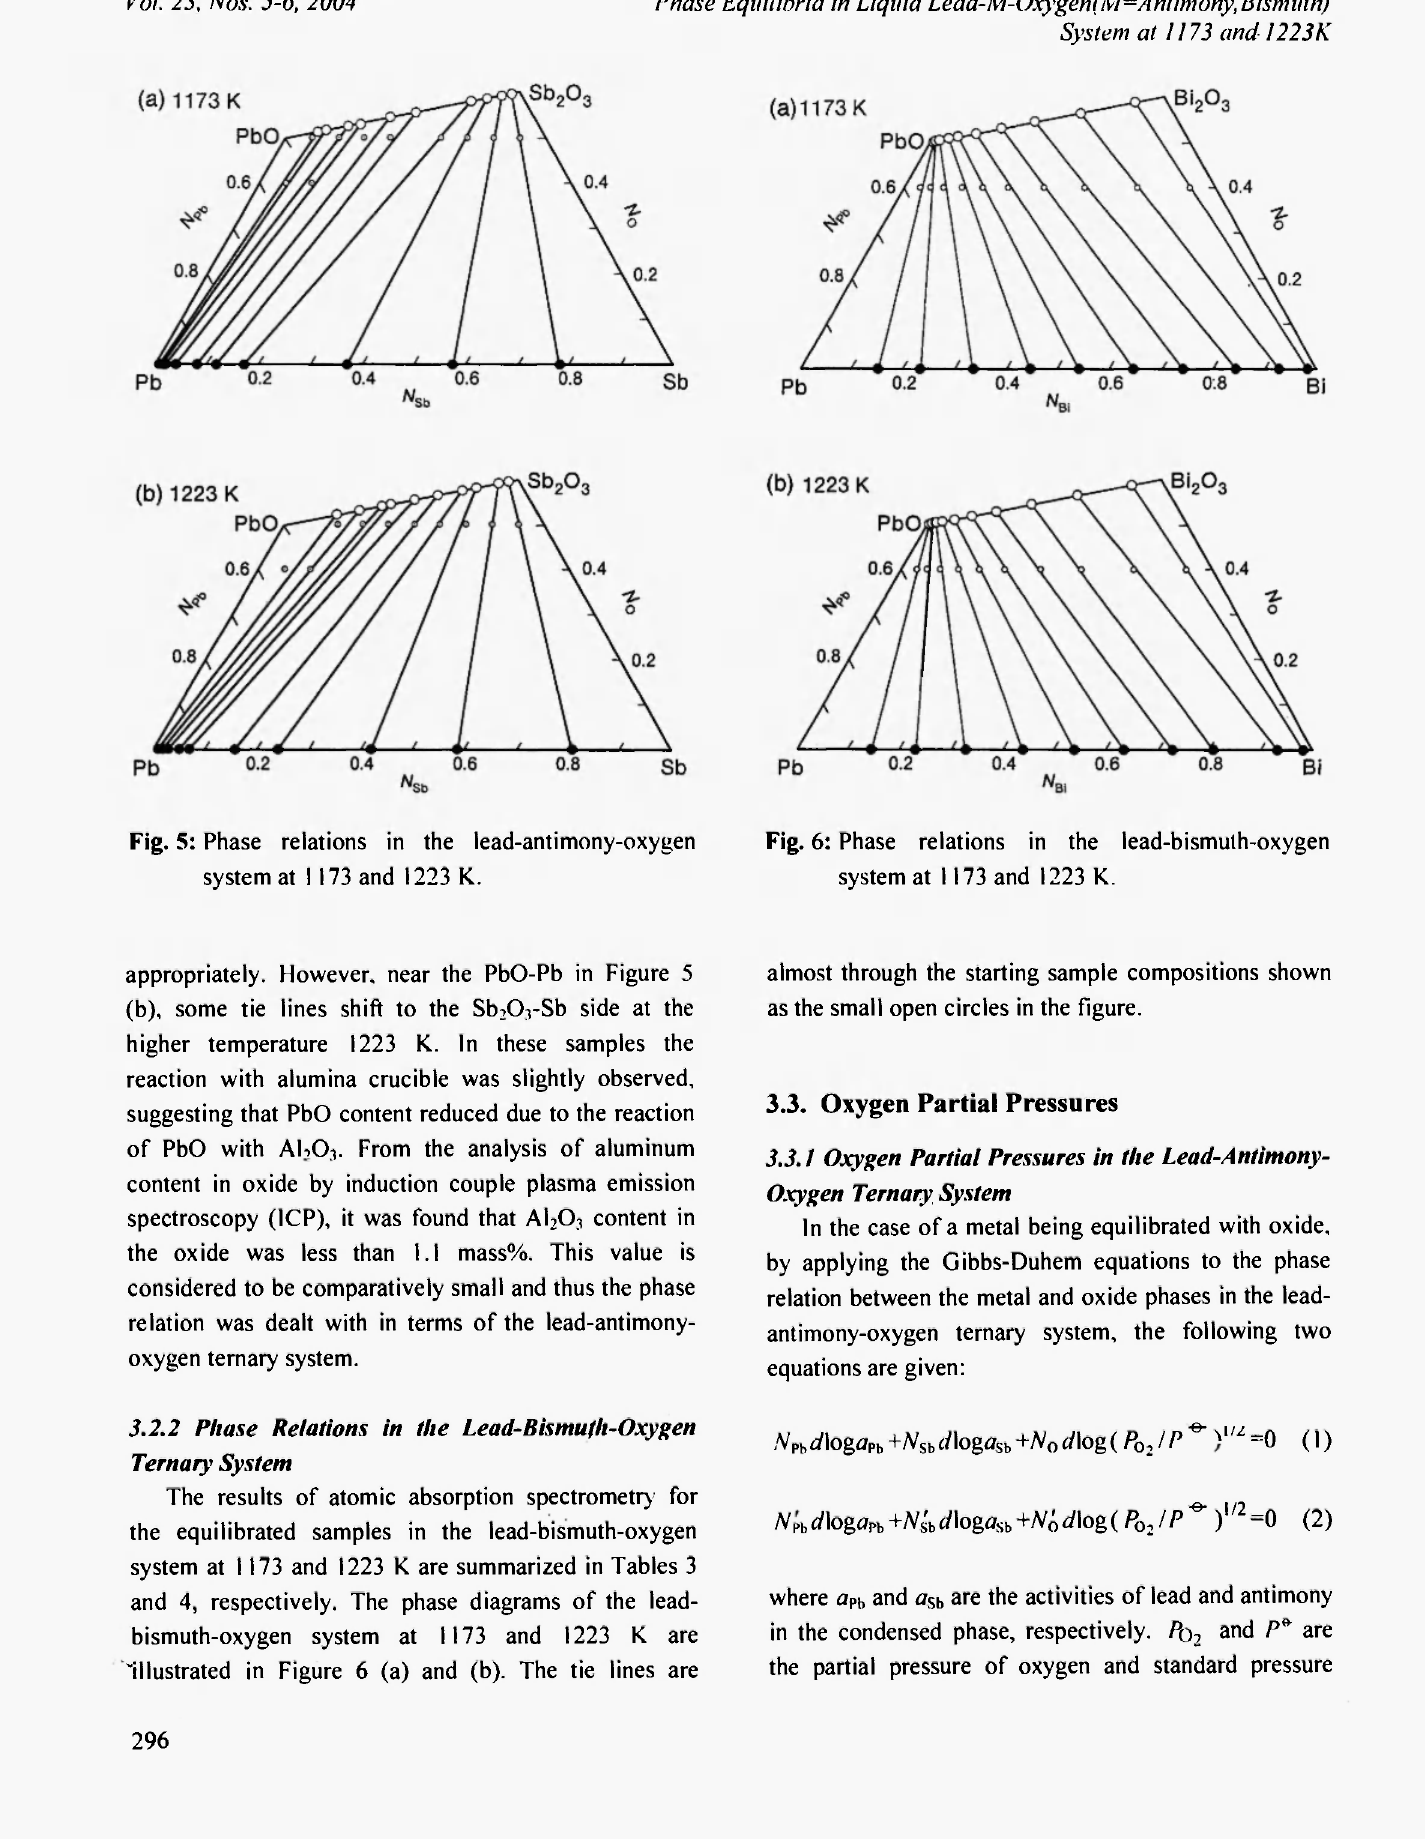
Fig. 6: Phase relations in the lead-bismulh-oxygen system at 1173 and 1223